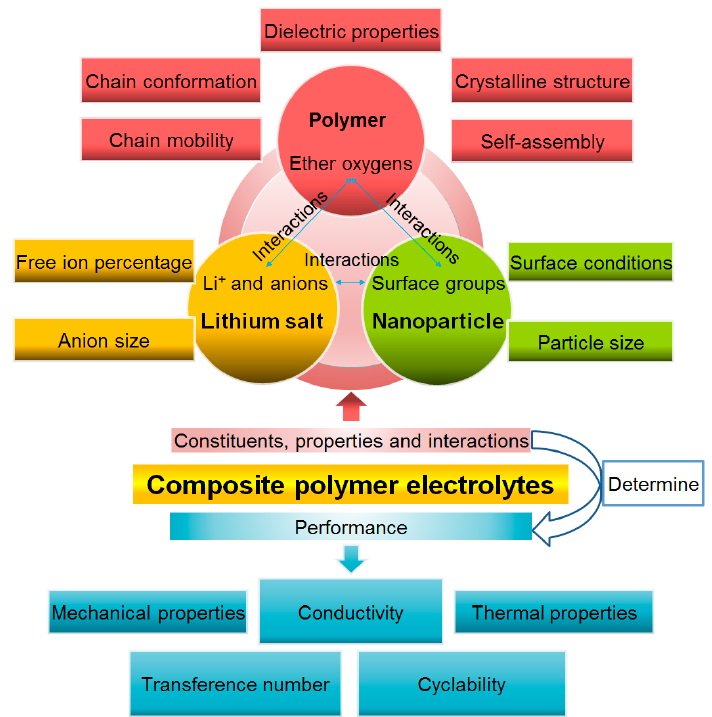
Figure 1. Knowledge network for the study of composite polymer electrolytes.